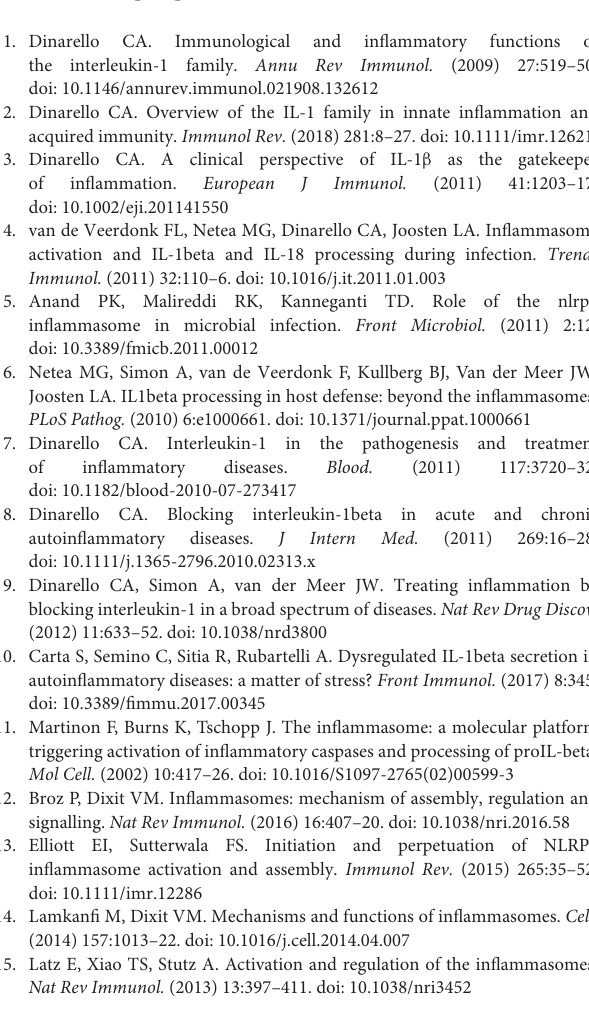
multiple templates for individual LRRs. Templates with over 30% sequence identity were selected for modeling and aligned using PyMOL to calculate root mean square score (rms) compared to NLRP3 LRRs. NLRP2 LRRs had the lowest rms score with more than 80% coverage and was selected to substitute for those of NLRP3. (B) Aligned homology models of the LRRs of NLRP3 (black) and NLRP2 (gray). Details of alignment and template characteristics in tabular form (left). Images from rotation of aligned models on the X- and Y- axis with the respective degree of rotation on individual axes (right). Figure S2 | Characterization of NLRP3 N-terminal region. (A) Schematic of the exon structure coding linker domains for all NLRPs. (B) Multiple sequence alignment of Pyrin domain and linker region for NLRPs known to interact with ASC. (C) Multiple sequence alignment of NLRP3 across different species (Red bar indicates the Pyrin domain). (D) Fluorescence imaging and quantification of specks in HEK293T cells expressing myc-ASC and NLRP3 or NLRP3 1–93. Figure S3 | Structural alignment of NLRP1, NLRP2, and NLRP3 PYD. (A) Multiple sequence alignment of the Pyrin domains of NLRP1, 2, and 3 with sequence identities and similarities. (B,C) Aligned homology models of the (B) Pyrin domains of NLRP3 (red) and NLRP1 (blue) and (C) the NLRP3 (red) and NLRP2 (green) LRRs. Details of alignment and template characteristics in tabular form (top).